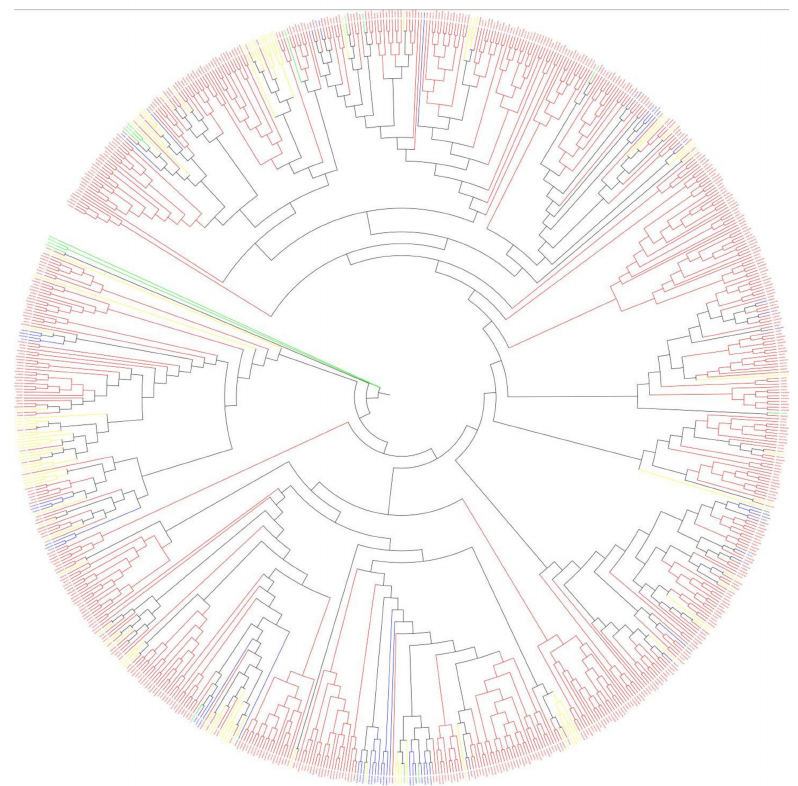
Figure 5. Phylogenetic tree of the 2OGD genes in Brassica species and A. thaliana . The DOXA class, DOXB class, DOXC class, and Unclassified are coloured blue, yellow, red, and green,